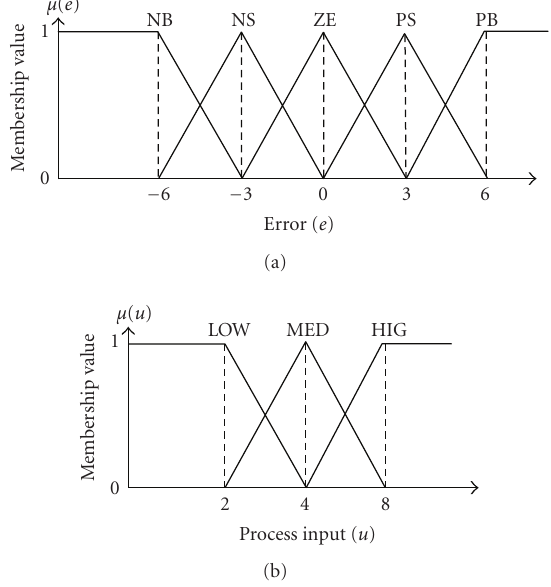
Figure 2: Fuzzy output membership functions (a) error (b) process input.